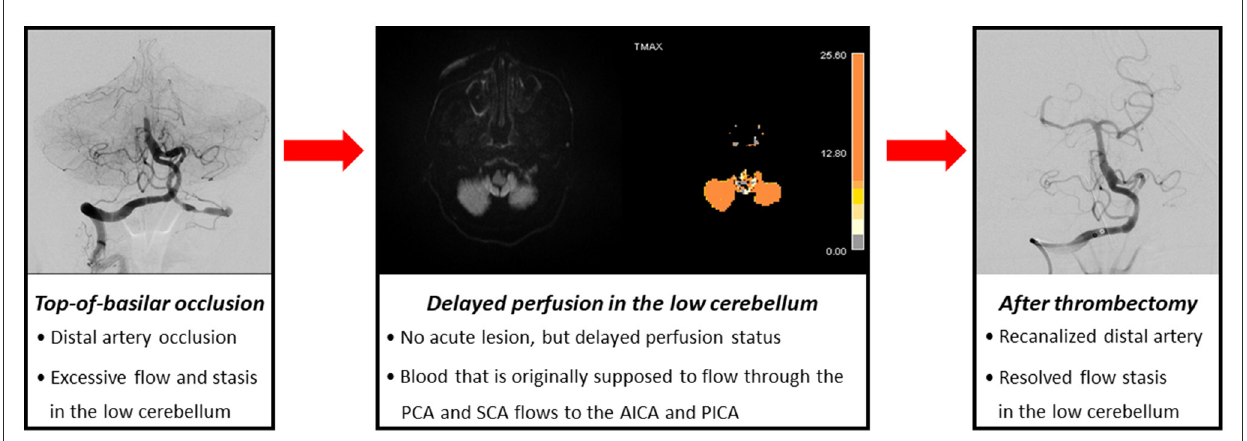
FIGURE2 Hypothesis regarding excessive blood flow and stasis proximal to the occlusion site in top-of-basilar occlusion.